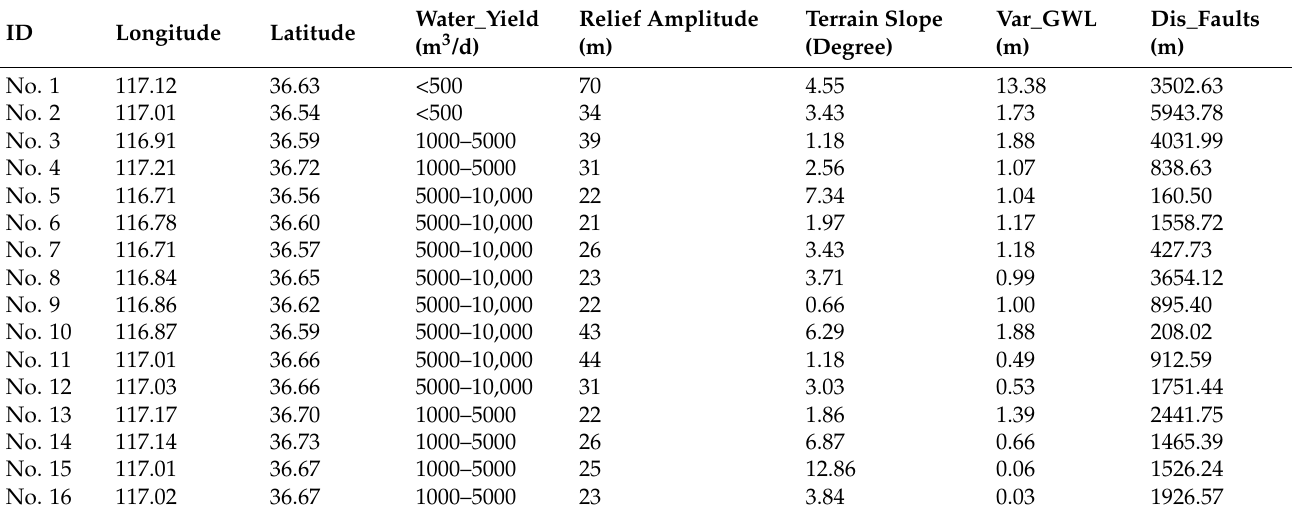
Table A1. Hydrogeological characteristics data of all observation